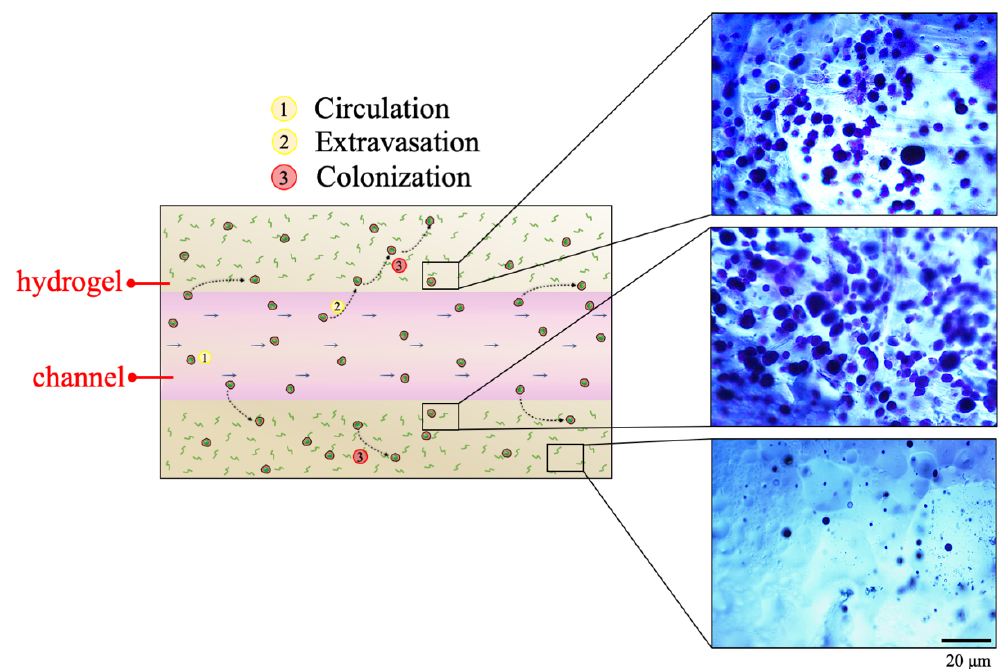
Figure 9. Toluidine blue staining on fibrin hydrogel identifying cells extravasated and migrated within the fibrin hydrogel.